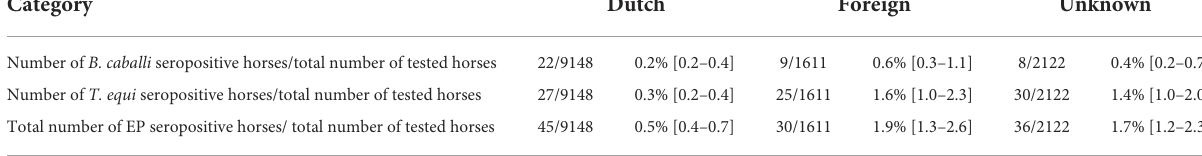
TABLE 1 Total numbers of seropositive horses for B. caballi , T. equi and combined (“EP seropositive”) compared to the total of horses tested between 2015 through to 2020 per category based on microchip numbers (“Dutch,” “Foreign” and “Unknown”). Category Dutch